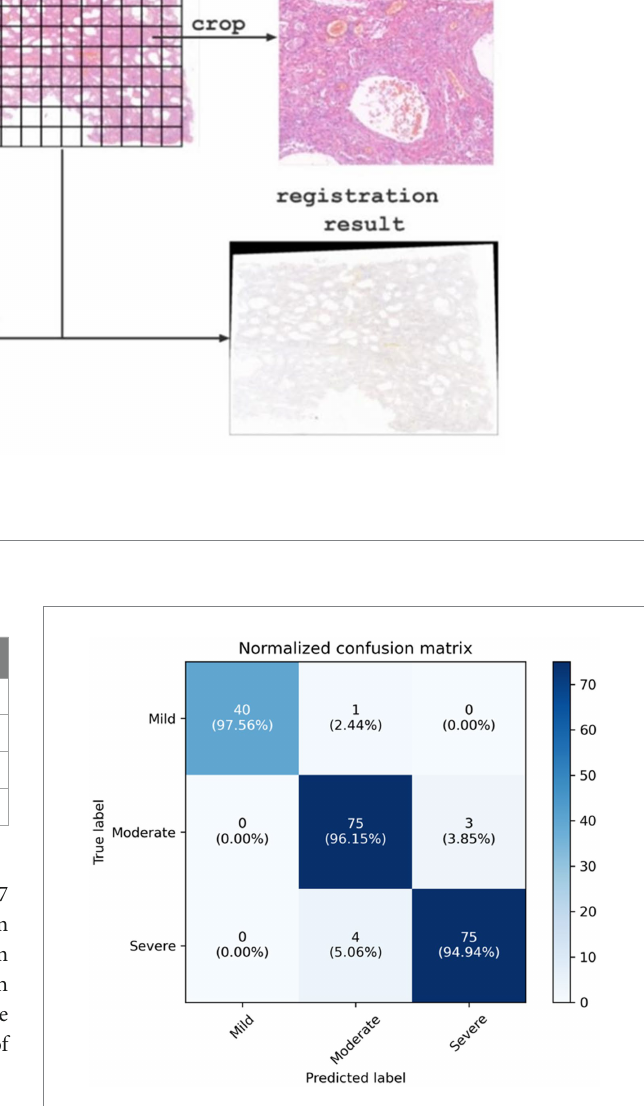
FIGURE 4 The normalized confusion matrix for the classification task.